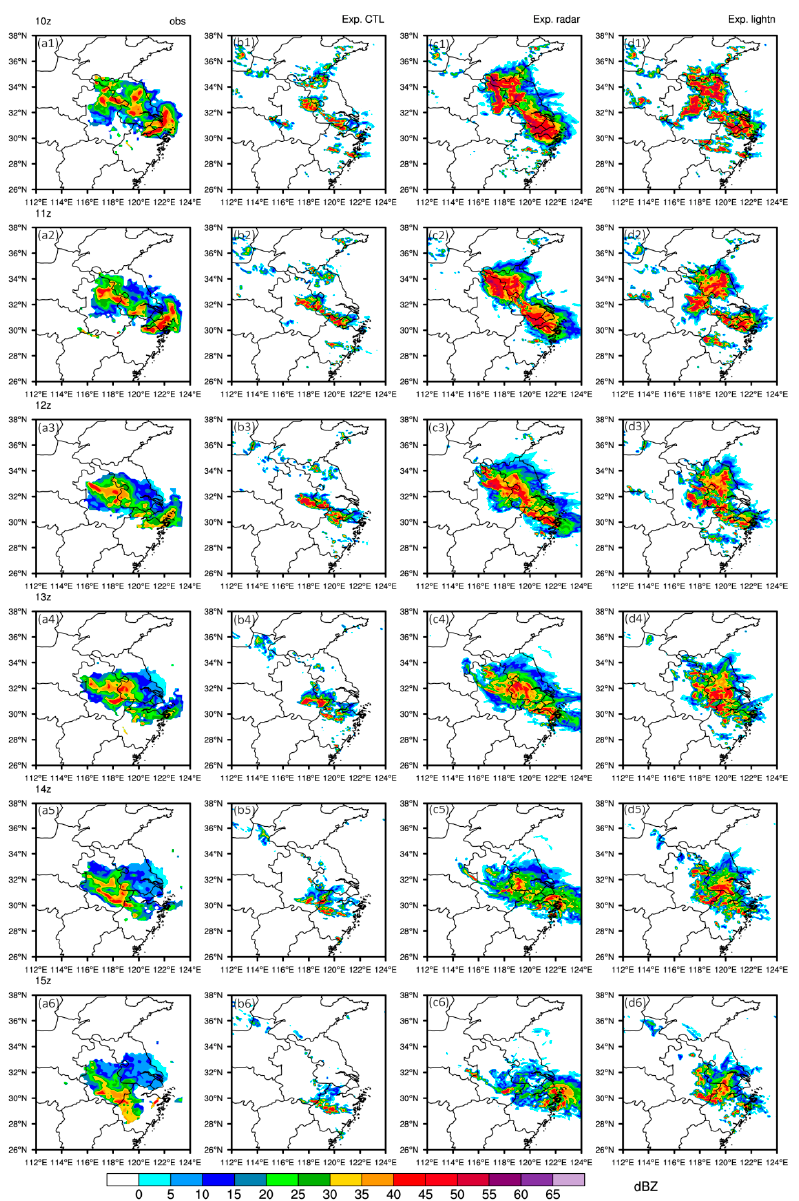
Figure 3. The observed maximum reflectivity ( a ) and forecast maximum reflectivity of ( b ) Exp. CTL, ( c ) Exp. radar and ( d ) Exp. lightn from 1000 to 1500 UTC (unit: dBZ). Line 1 to 6 represents different time point from 1000 to 1500 UTC.